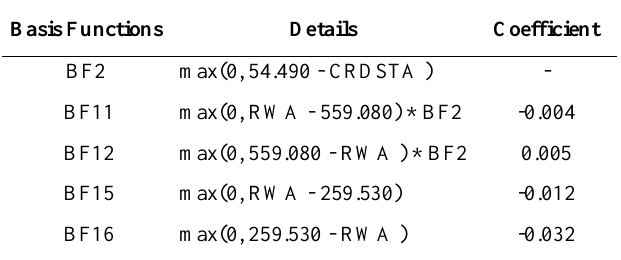
Table 8: Basis Functions of RWA